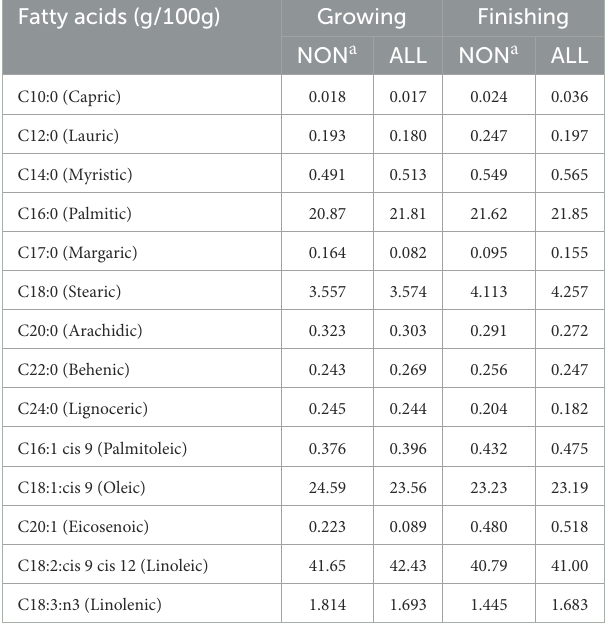
TABLE 3 Fatty acid profile of growing and finishing diets of Experiment 2. Fatty acids (g/100g)